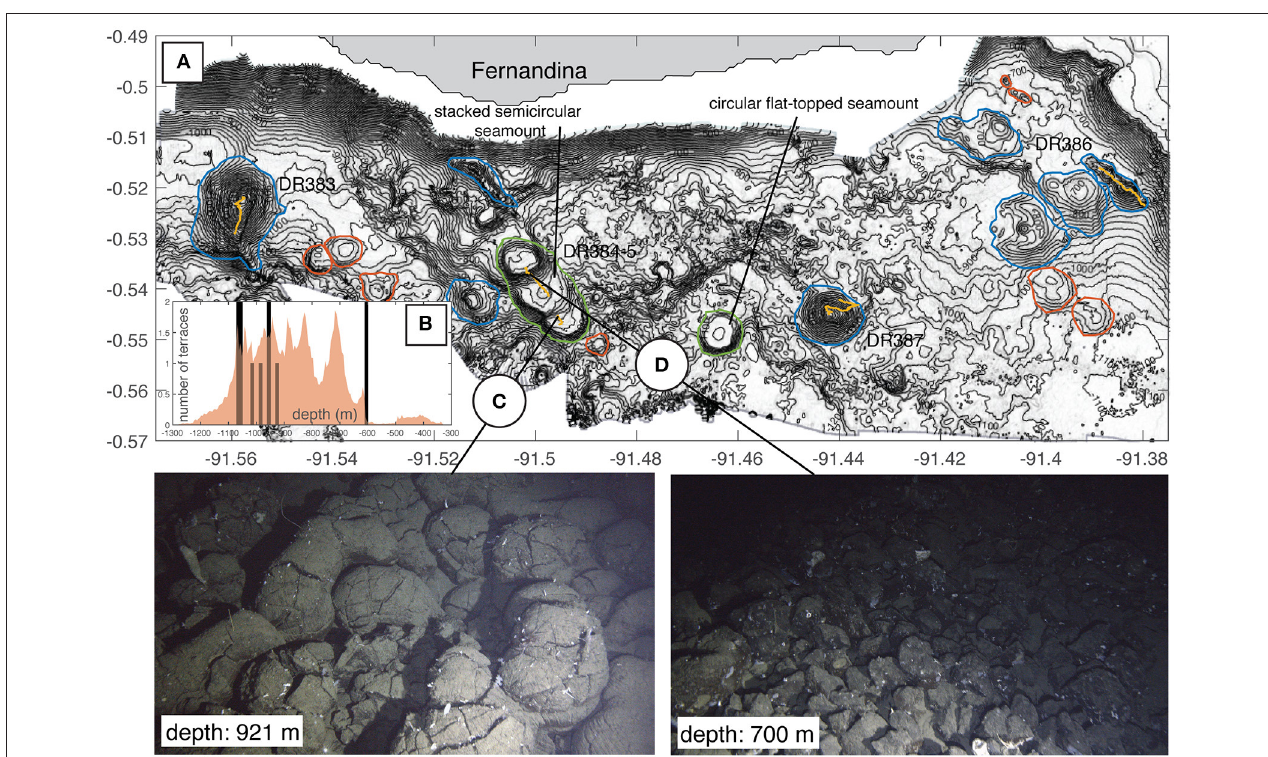
FIGURE 9 | (A) Bathymetric map of the Fernandina seamounts. Gray polygon indicates island location. Bathymetric contour interval is 20m. Green lines indicate footprints for seamounts > 100m of relief that have identified terraces. Blue lines indicate other mapped seamounts > 100m. Red lines indicate mapped seamounts, which are < 100m in relief. Gold lines indicate dive tracks. (B) Histogram of depths of identified terraces. Semi-transparent red polygon shows the probability distribution of all depths within the mapped seamount footprints. (C) Pillow lavas, which serve as the bedrock for the lowermost terrace on this seamount. (D)